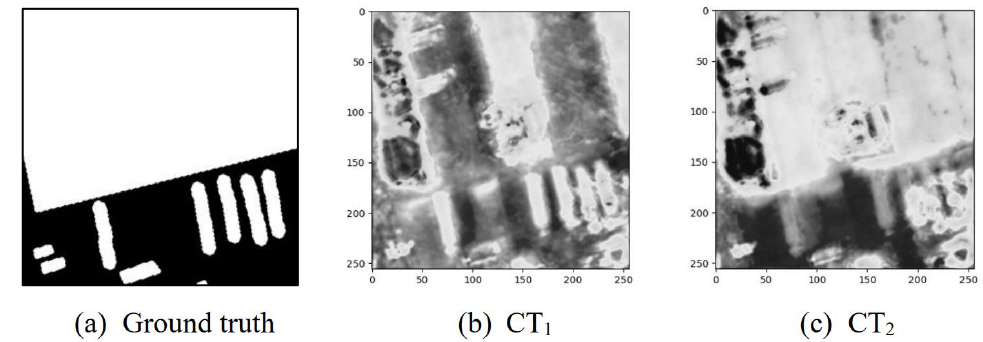
Figure 5. Example of independent difference feature maps on average for CT 1 and CT 2 .